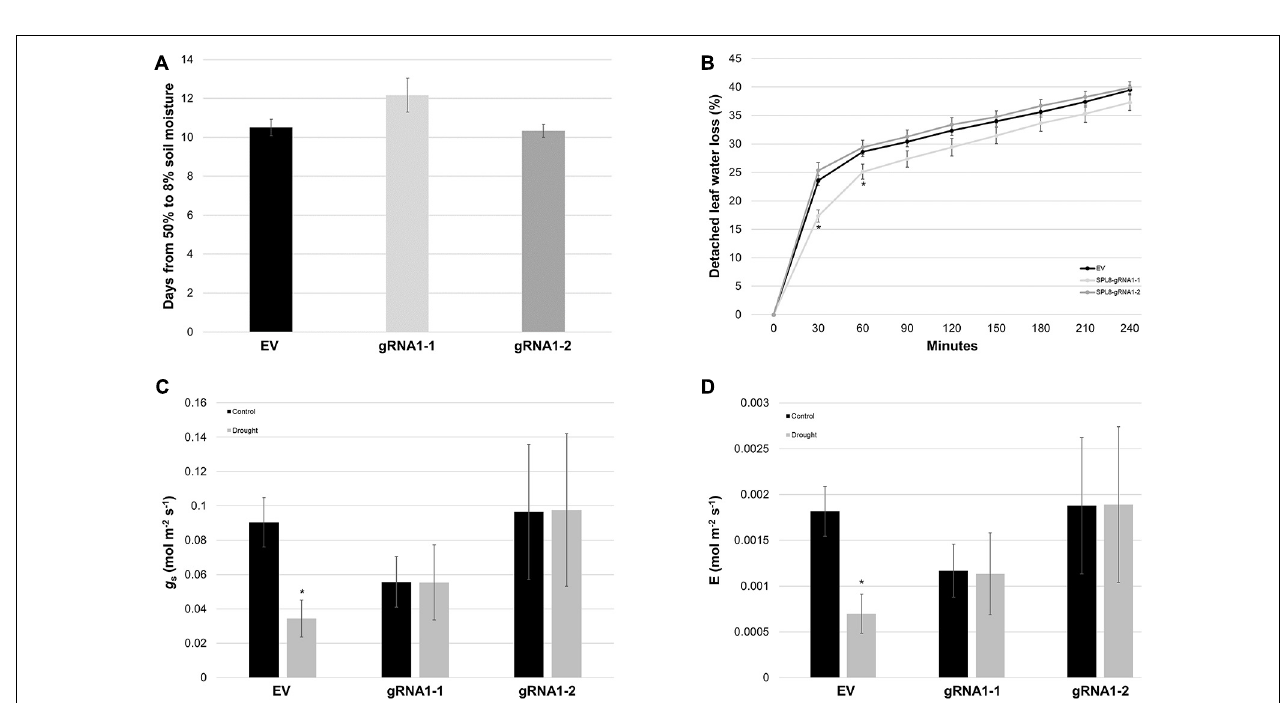
FIGURE 7 | Water loss-related traits in SPL8-gRNA1 and EV genotypes. (A) Number of days required for volumetric soil moisture contents to decrease from 50 to 8% following the withholding of water. Blocks denote the mean value of six SPL8-gRNA1-1, six SPL8-gRNA1-2 and eighteen EV (six each of three independent transformants) biological replicates derived from stem cuttings. (B) Rates of water loss from detached leaves derived from well-watered plants. Blocks denote the mean value of twelve SPL8-gRNA1-1 (two leaves from six plants), twelve SPL8-gRNA1-2 (two leaves from six plants) and thirty-six EV (twelve leaves from three independent transformants) biological replicates. (C,D) Stomatal conductance ( g s ) and transpiration rate (E) of middle leaflets from third fully expanded trifoliate leaves under well-watered (soil moisture content of approximately 50%) and drought (average soil moisture content of approximately 11%) conditions. Measurements were adjusted for leaf area and blocks represent the mean value of leaflets from four SPL8-gRNA1-1, four SPL8-gRNA1-2, and twelve EV (four each of three independent transformants) biological replicate plants derived from stem cuttings. For all graphs, bars denote standard errors and asterisks denote means that are statistically different in SPL8-gRNA1 genotypes compared to EV genotypes (B) or under drought compared to well-watered conditions (C,D) as determined by 1-tailed (C,D) or 2-tailed (B) t -tests assuming unequal variance (* P ≤ 0.05). gRNA1-1, SPL8-gRNA1-1; gRNA1-2, SPL8-gRNA1-2.